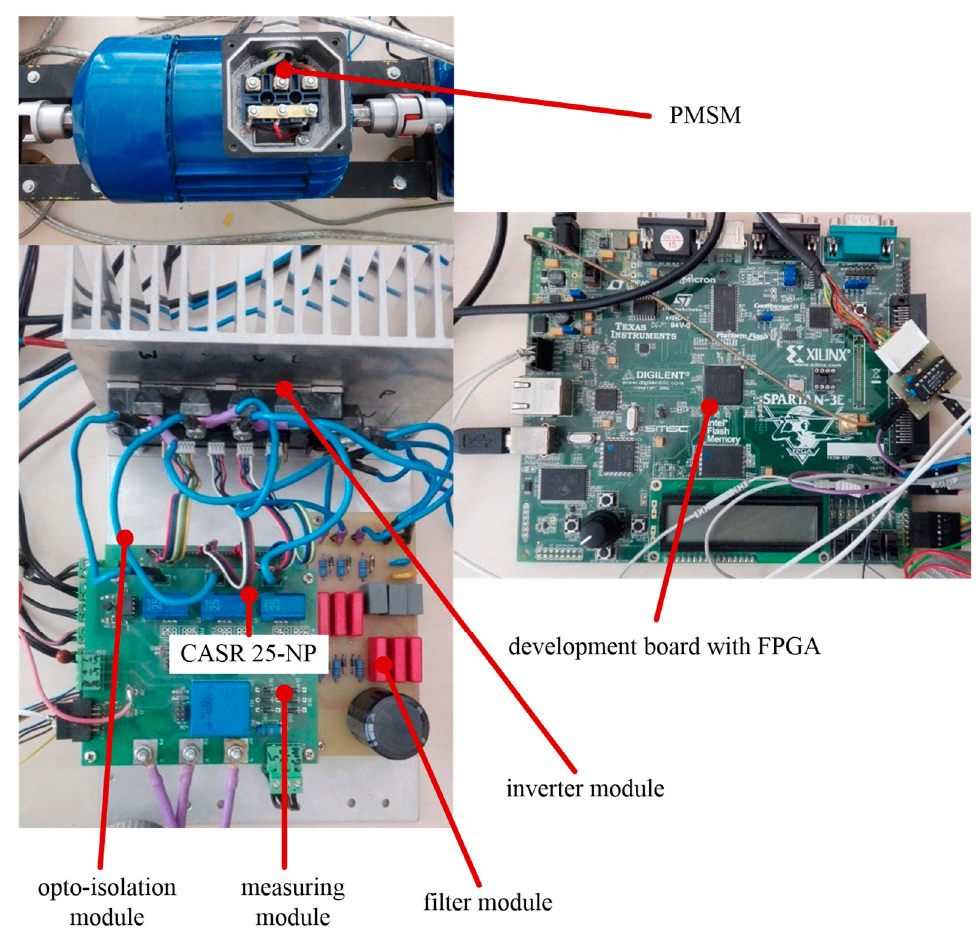
Figure 7. The picture view of the experimental setup with or field-programmable gate array (FPGA).